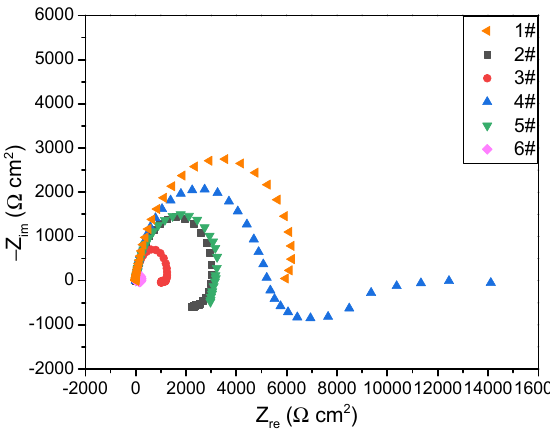
Figure 3. The Nyquist diagram of six alloys.